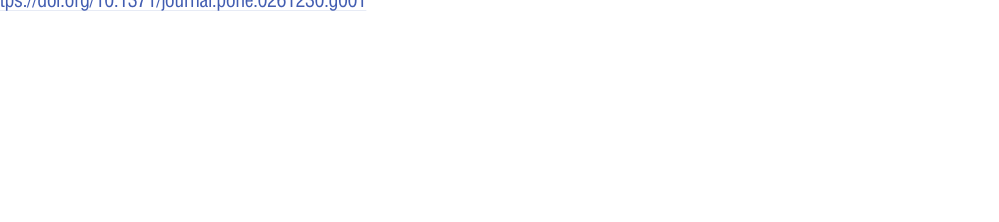
PLOS ONE | https://doi.org/10.1371/journal.pone.0261230 December17,